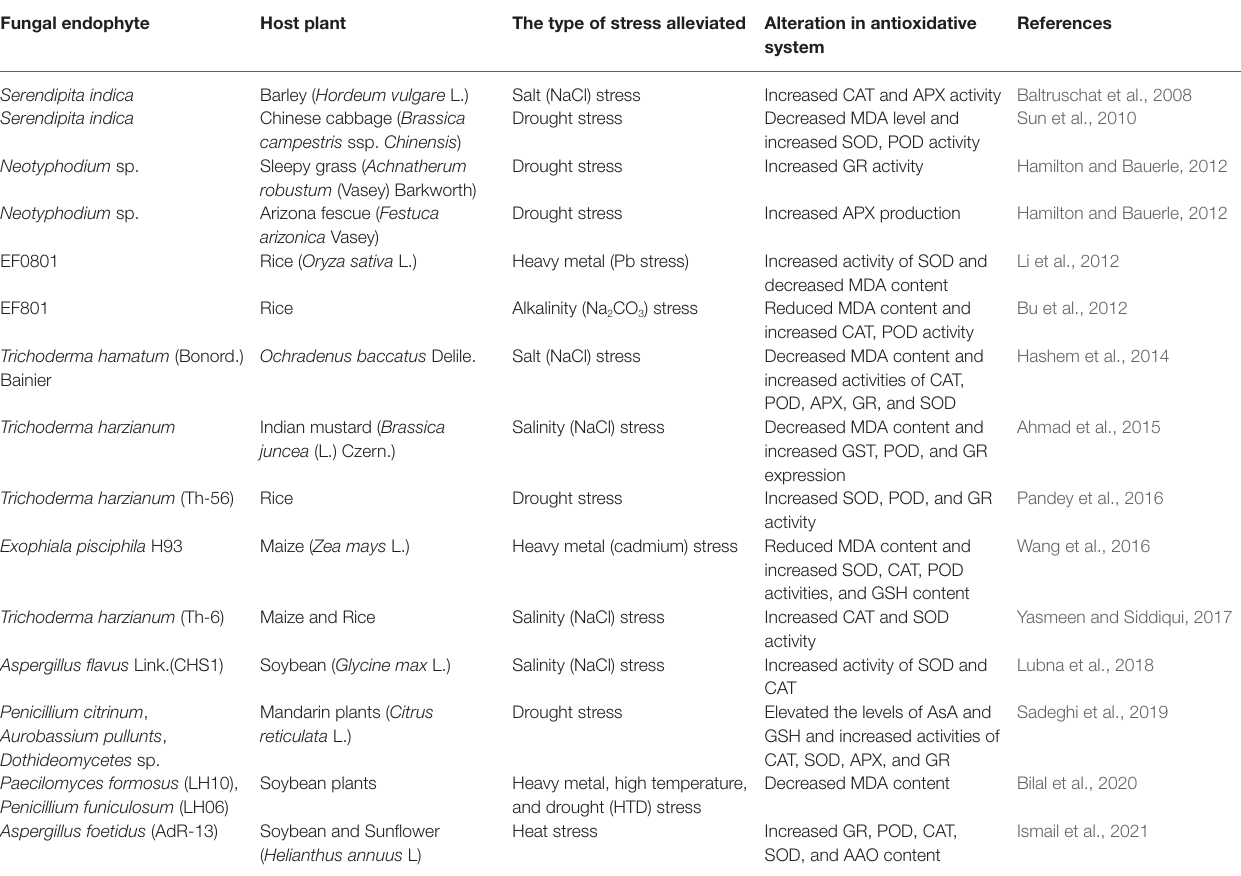
TABLE 4 | Different fungal endophytes which modulate the efficiency of antioxidative system to endow resistance against abiotic stress in host plants. Fungal